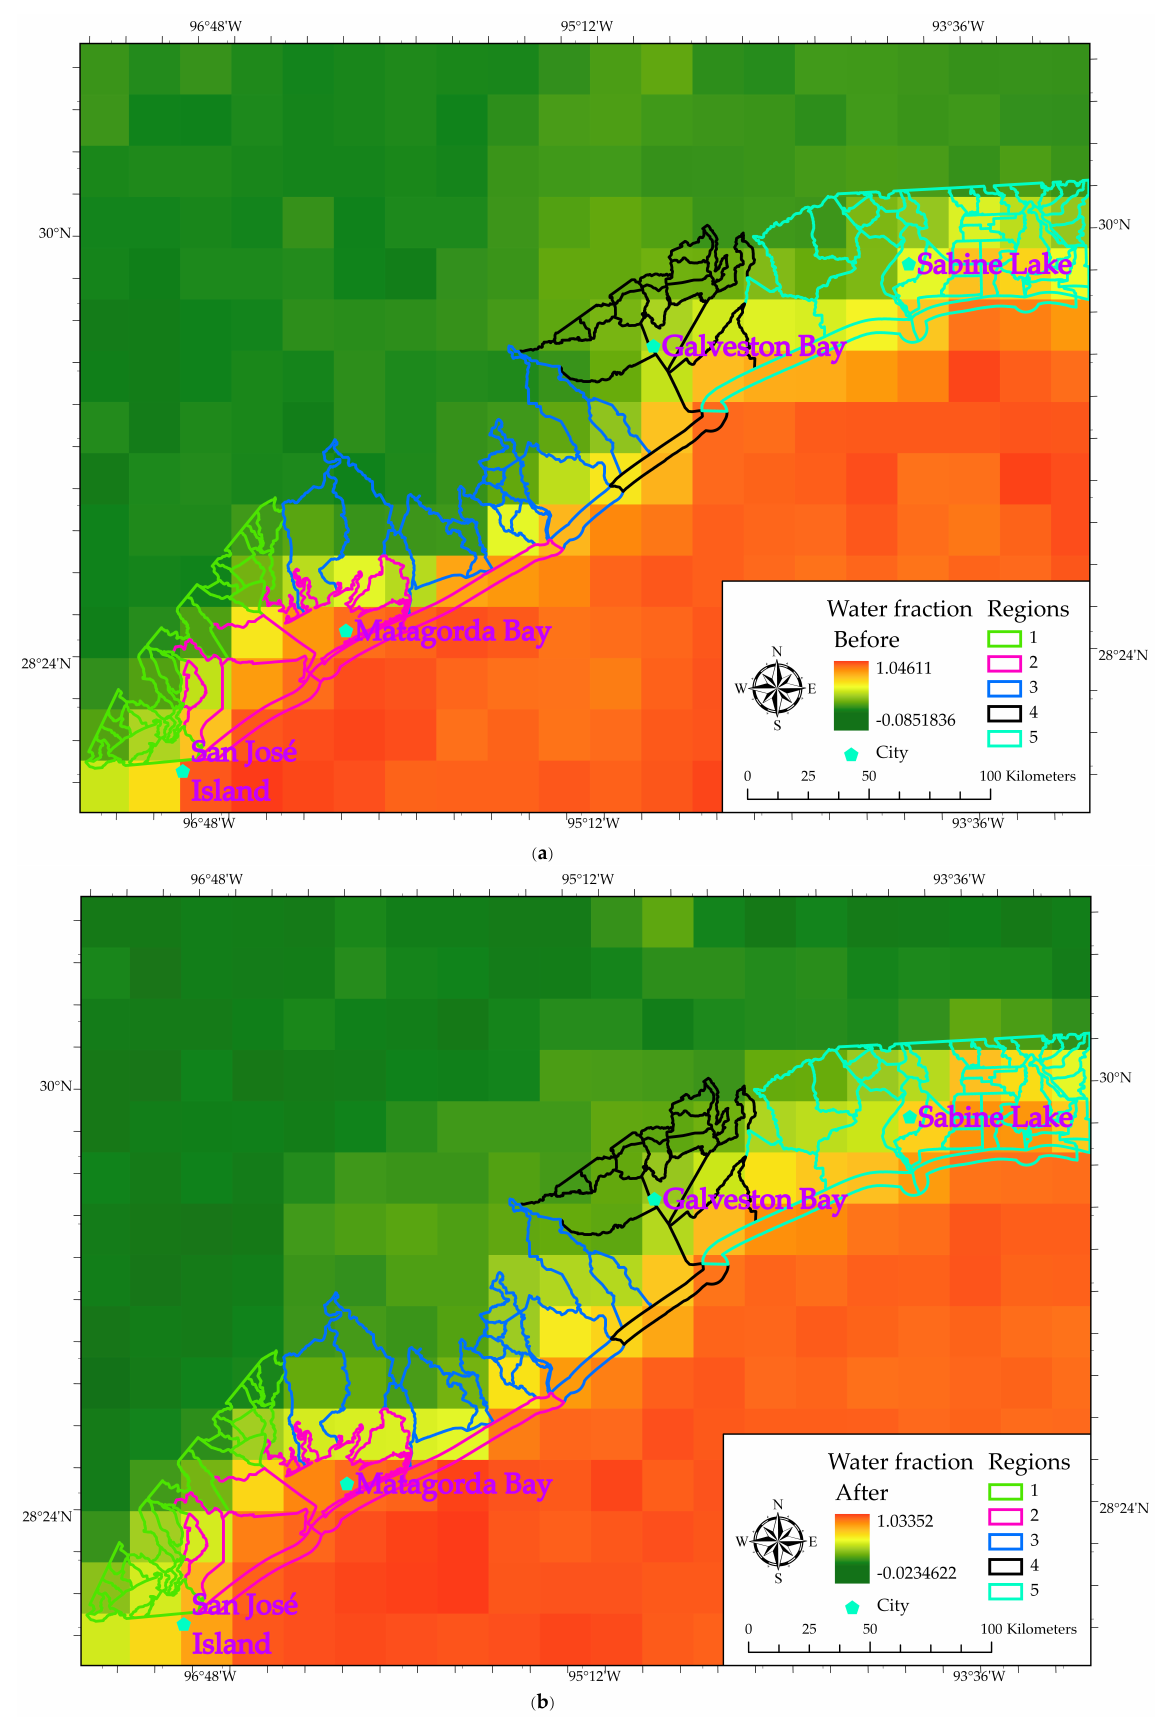
Figure 5. WF map before ( a ) and after ( b ) Hurricane